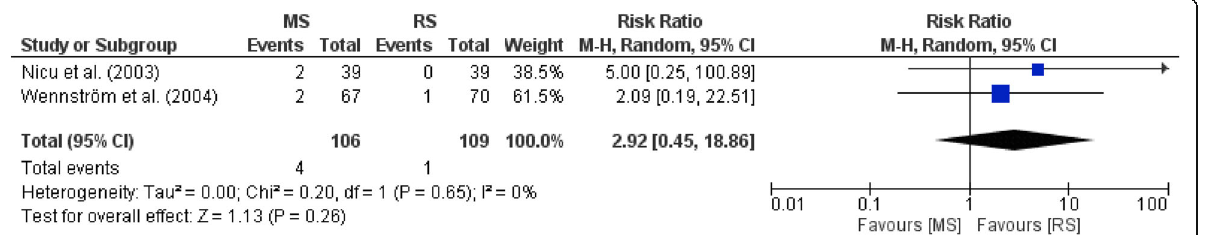
Fig. 5 Forest plot on differences in implant survival between MS and RS groups in all included RCT's